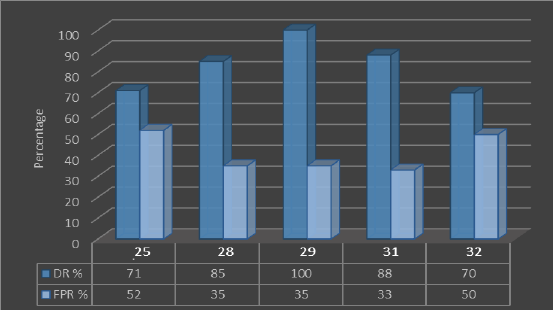
Figure 4. Accuracy of the detected outliers at different nodes.